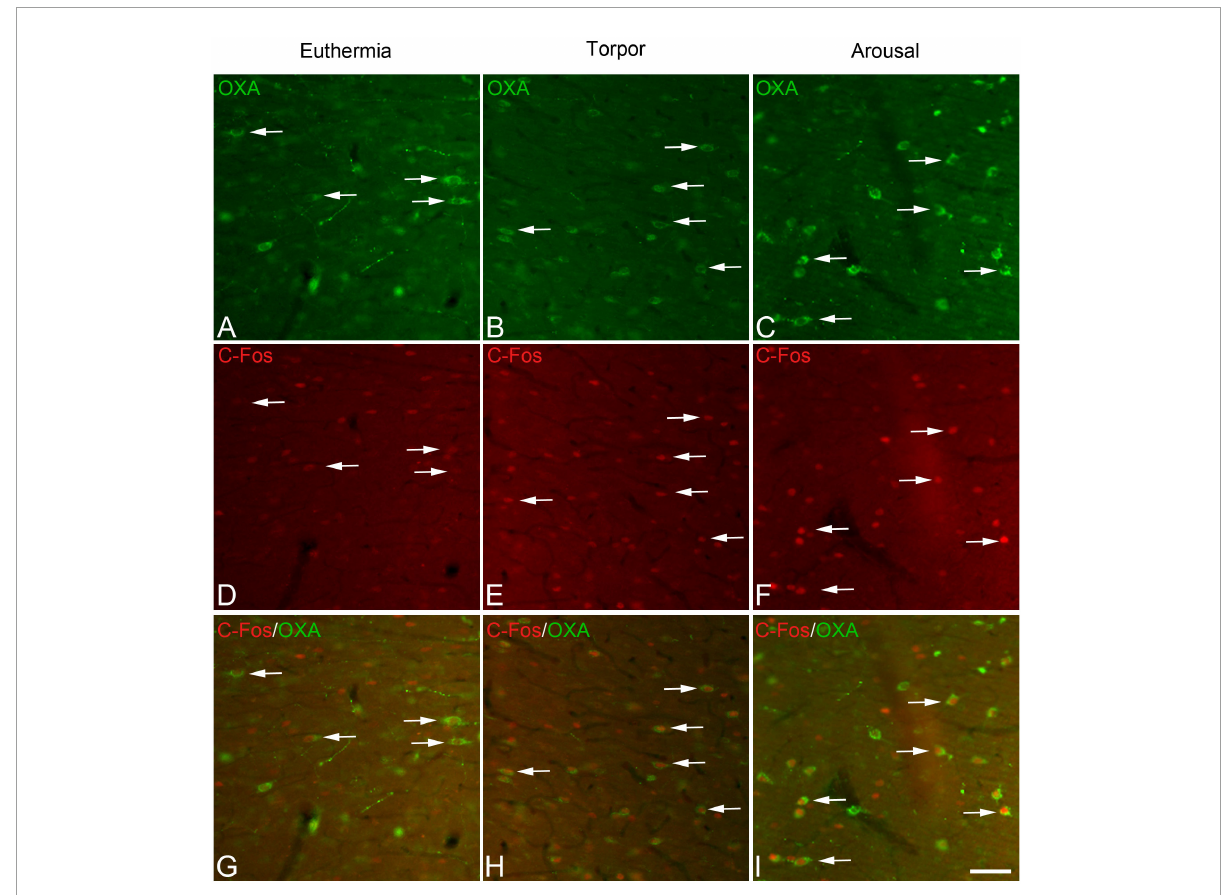
FIGURE3 Pairs (A/D, B/E, C/F) of fluorescence photomicrographs of OXA/C-Fos double-immunostained sections from the LH of Mesocricetus auratus showing the expression of the neuronal activity marker C-Fos (red) in orexinergic neurons (arrows) of hamsters in euthermic, arousal, and torpor states. (G,H) and (I) show merged images of (A/D, B/E, C/F) , respectively. Note the intense C-Fos labeling of LH in hamsters at arousal (F) . Scale bar, shown in panel (I) , indicates 60 µ